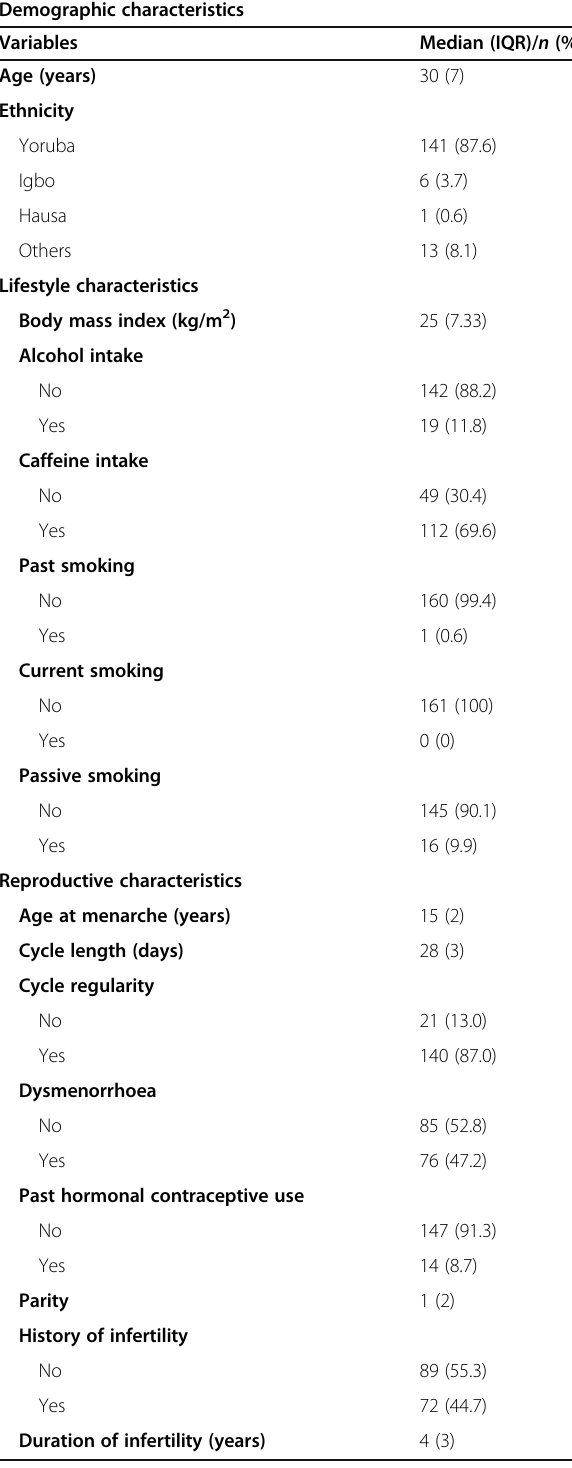
Table 1 Baseline